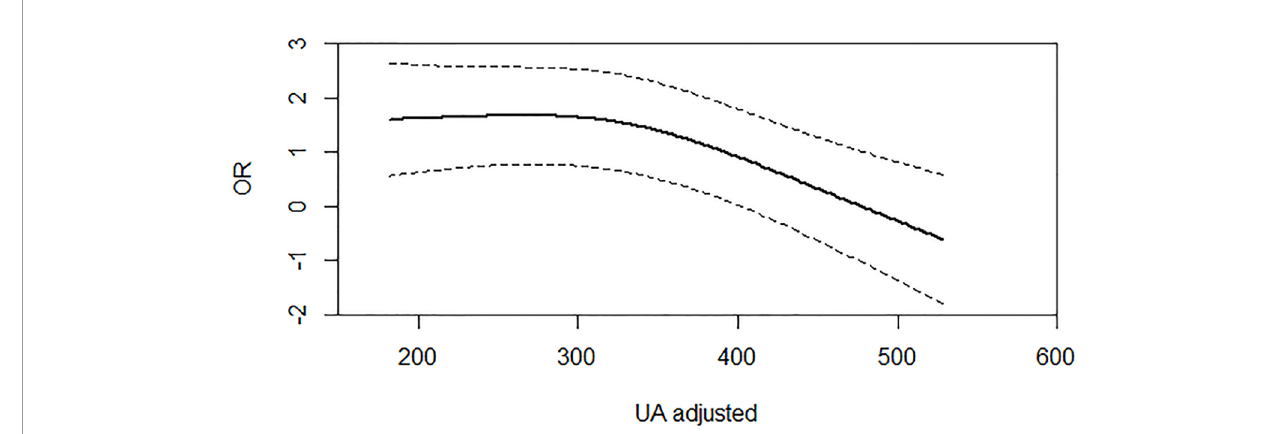
FIGURE 1 | Association of serum UA (uric acid) levels with risk of PSD. Dashed lines are 95% con fi dence intervals. Odds ratios and 95% con fi dence intervals derived from restricted cubic spline regression ( P for nonlinear = 0.0119). Odds ratios were estimated using logistic regression modeling, adjusting for the same variables as model 3 in Table 4